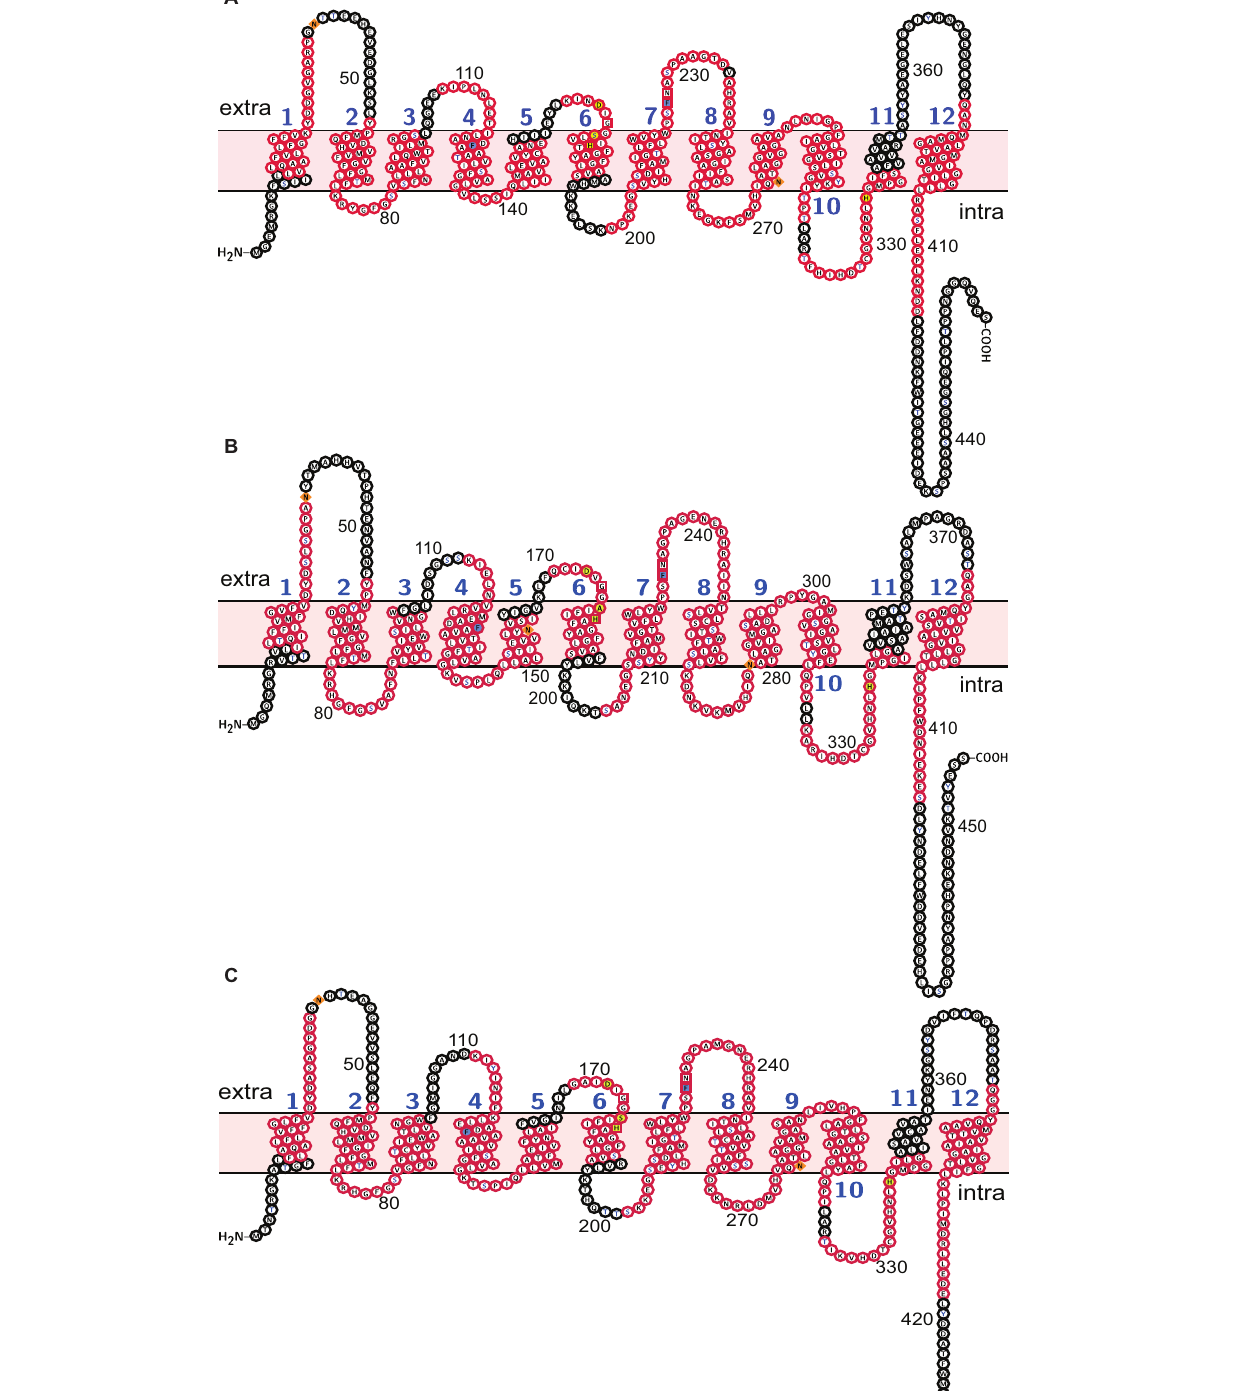
Frontiers in Marine Science |